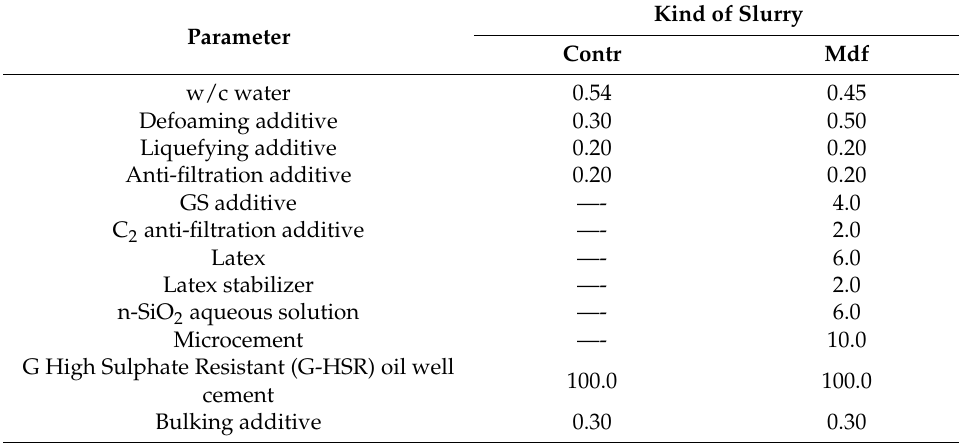
Table 1. Base slurry and slurry with selected additives and admixtures.